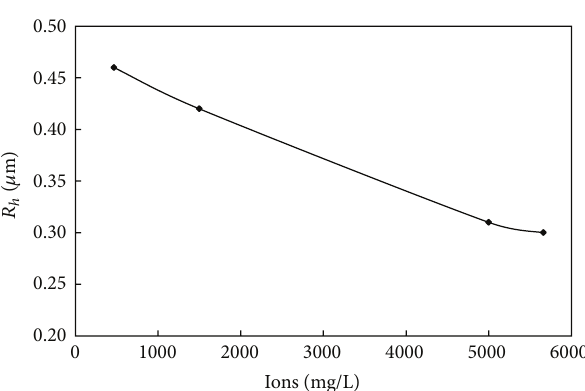
Figure 5: Pressure gradient distributions between